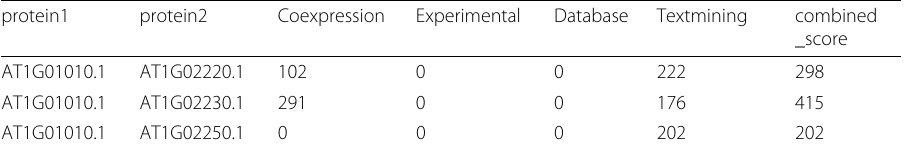
Table 1 Examples for proteins interactions extracted from the open STRING database used to construct proteins